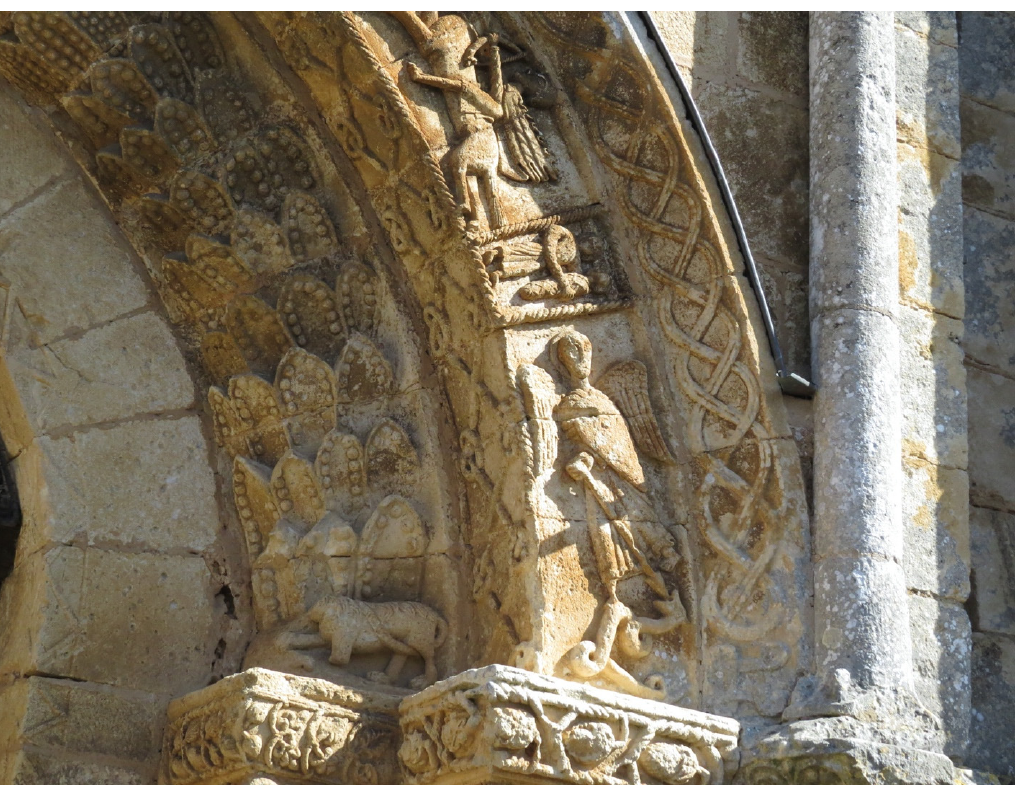
Figure 13. Lions, foliage, and frieze, detail of right-hand side, west façade, Saint-Martin Church , 12th c., Besse, Dordogne, Nouvelle-Aquitaine, France. ©Author.